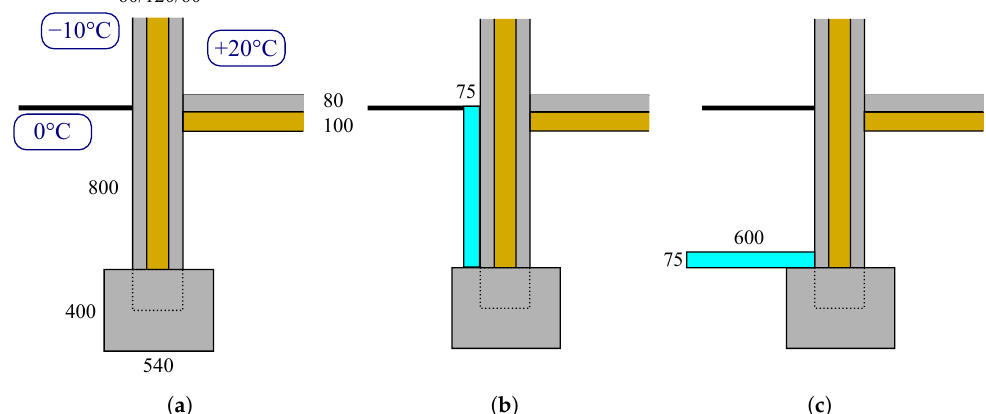
Figure 2. Dimensions of the foundation, temperatures and arrangements of external insulation considered in the present study: ( a ) no additional external insulation, ( b ) additional vertical insulation and ( c ) additional horizontal